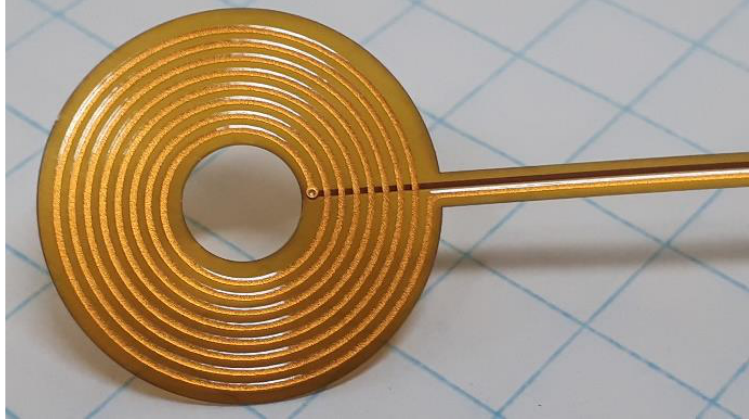
Figure 1. Picture of a PCB spiral copper coil.